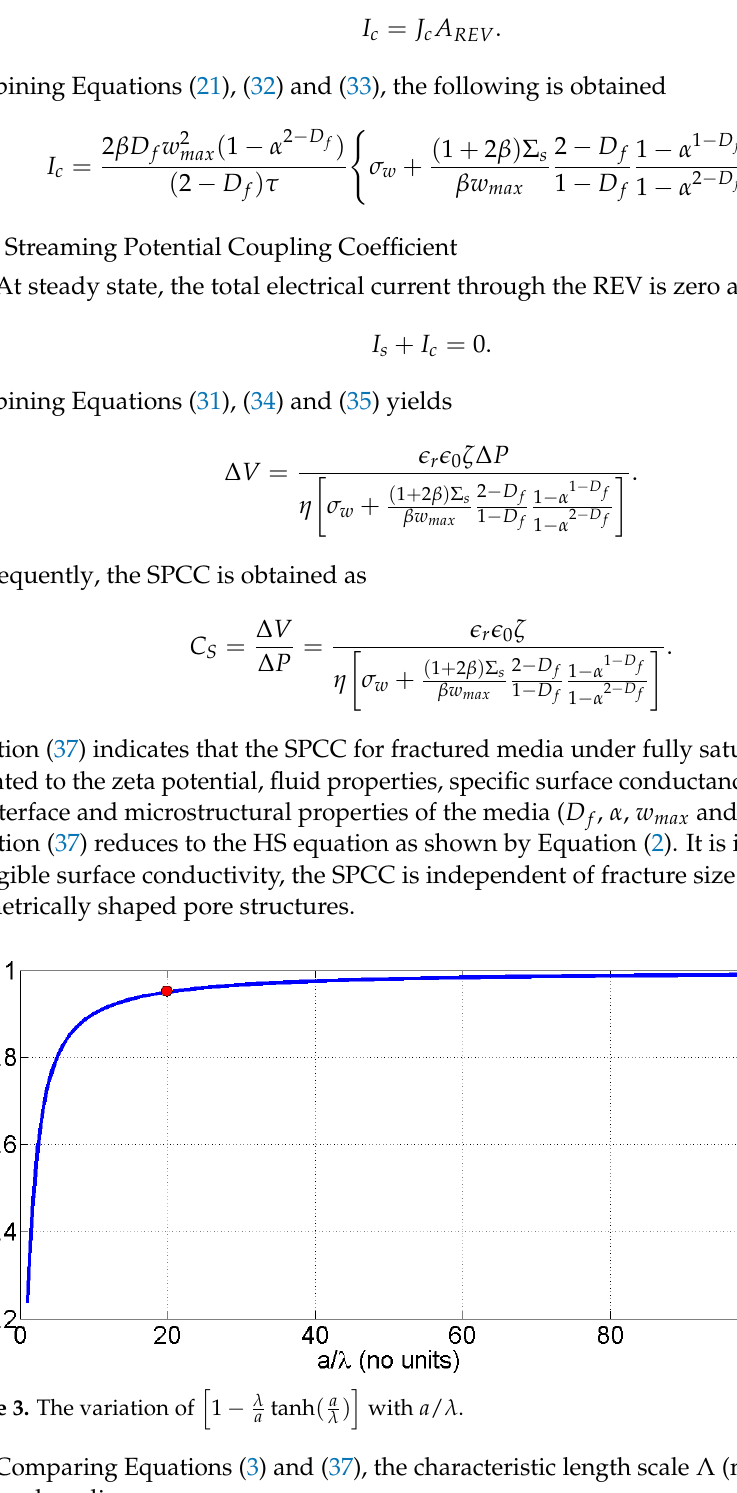
(cid:104) (cid:105) ) 1 − λ tanh ( a with a / λ . a λ